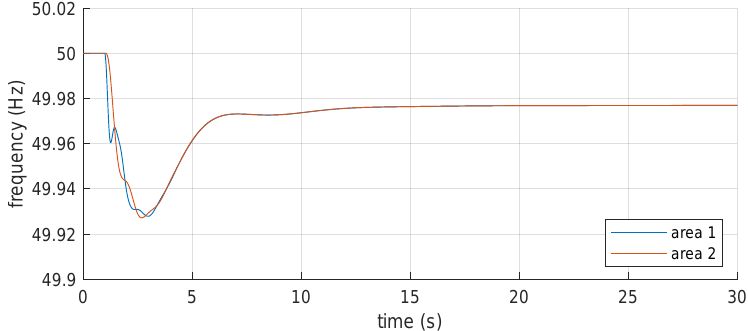
Figure 10. Grid-following in both